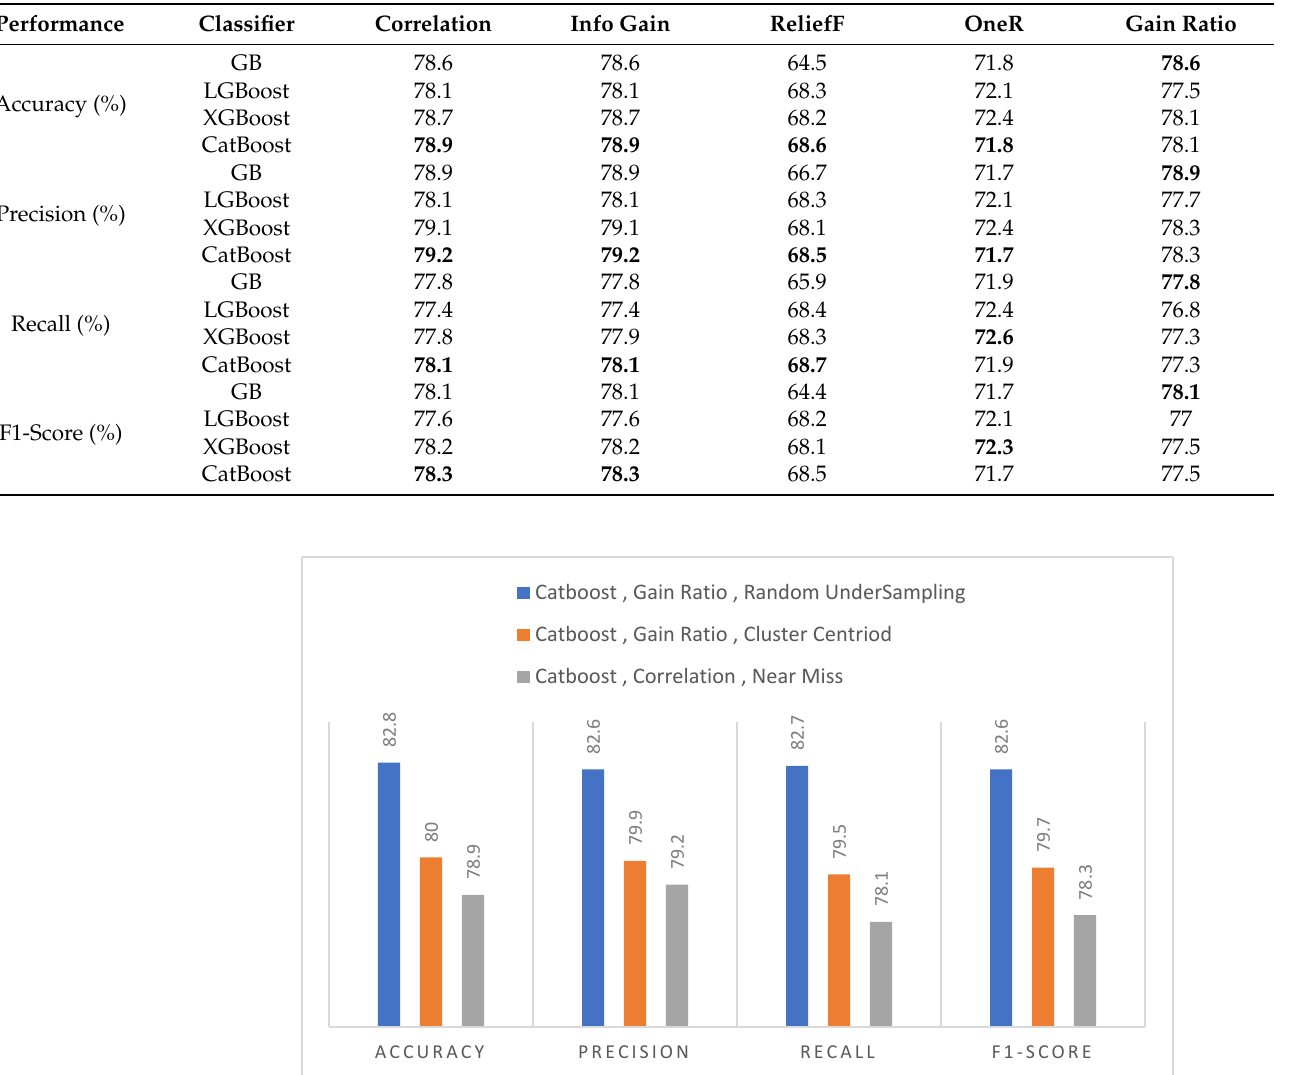
Table 7. Results of Near Miss with respect to each feature selection technique. Performance